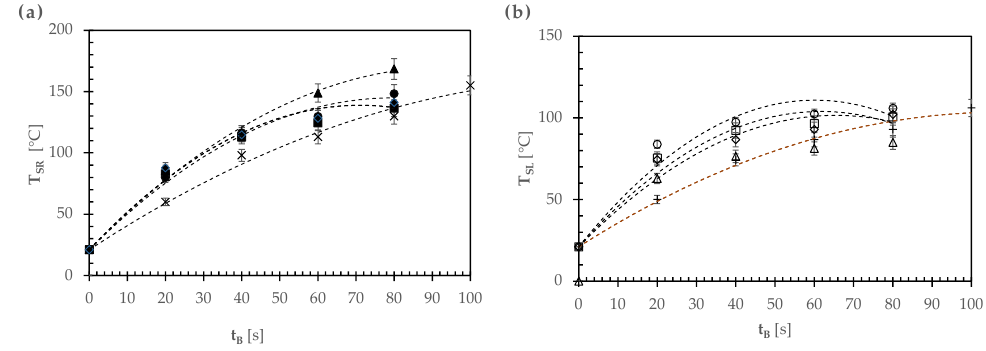
Figure 4. Time course of the average temperatures of ( a ) the raised rim (T SR : closed and × symbols) and ( b ) lower area (T SL : open and + symbols) of all the pizza samples during the baking tests of different pizza types: A, • , ; B, (cid:78) , (cid:52) ; C, (cid:4) , (cid:3) ; D, ♦ , (cid:7) ; E, × , +. The broken lines were calculated using the specific least squares quadratic regressions.